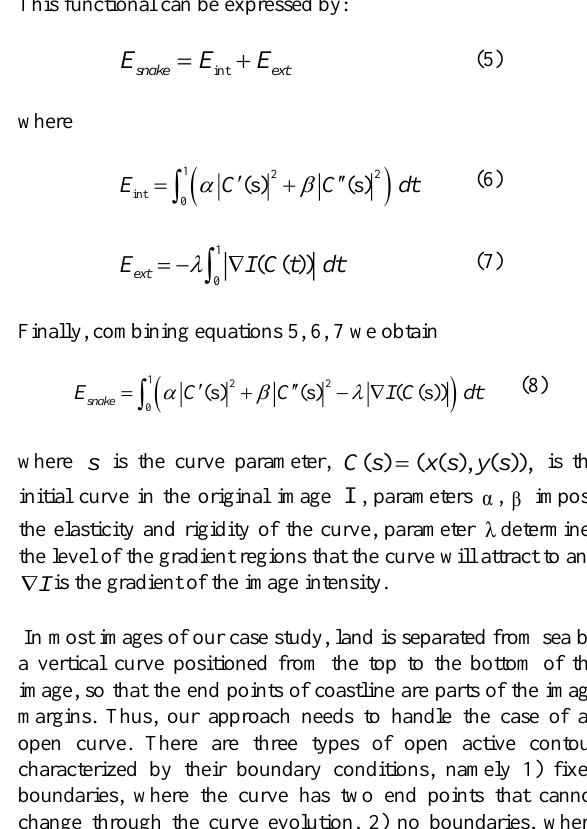
Figure 5. Estimation of first approach: (a), (b) close-up of the initial image in two different locations. Blue line reflects the estimated